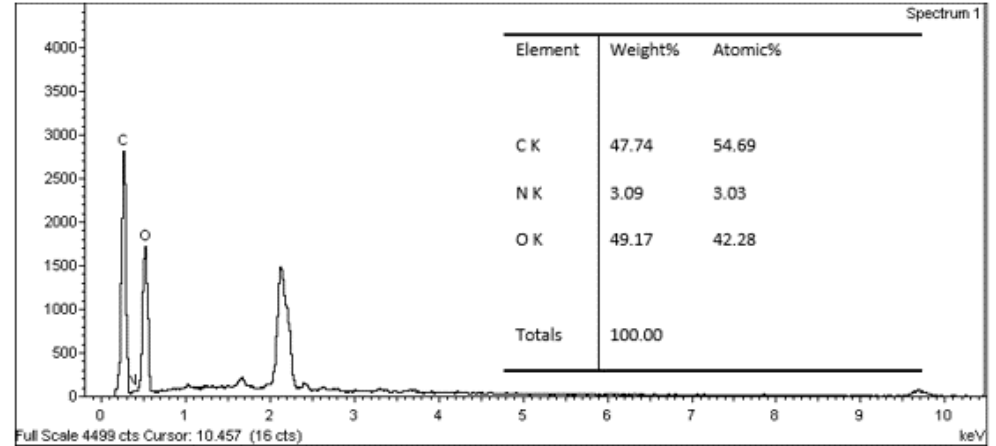
Figure 11. Energy dispersive X-ray spectrum for Rhizophora spp. particleboard bonded with 6% binders.